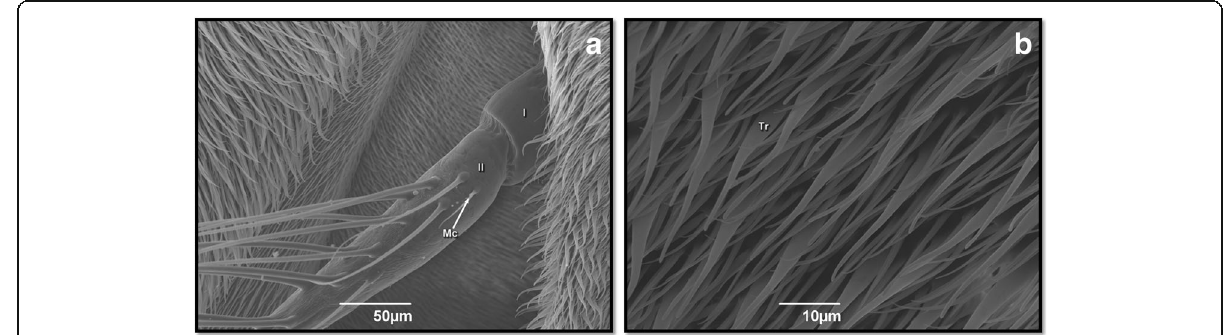
Fig. 10 Scanning electron micrographs showing the cuticular surface of flagellum of male of Mesembrinella semihyalina : a arista divided in two (I-II) segments (× 450); b first flagellomere (× 1,900). Fn = first flagellomere; Mc = microtrichia; Tr = trichoidea